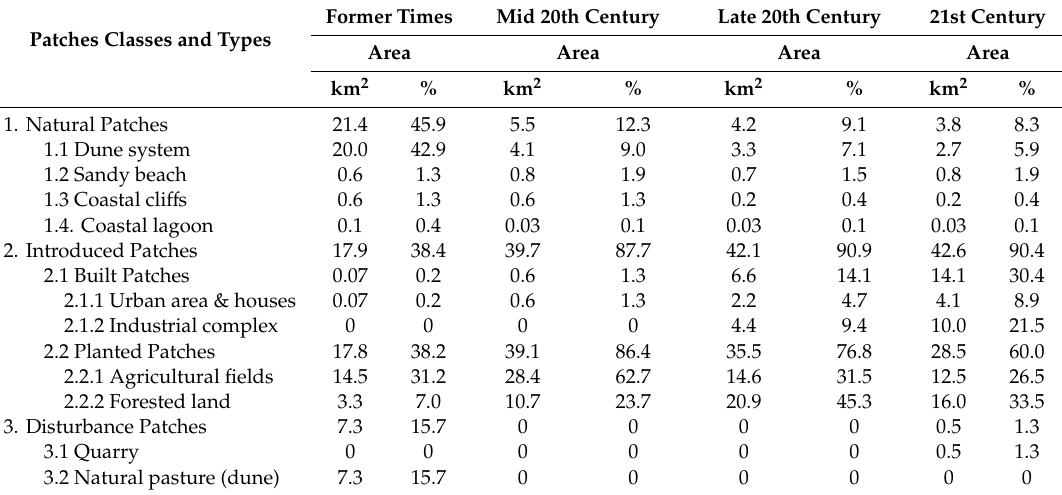
Table 1. Sines cape landscape mosaic change: patches total area (km 2 ) and proportion of the study area (%) over